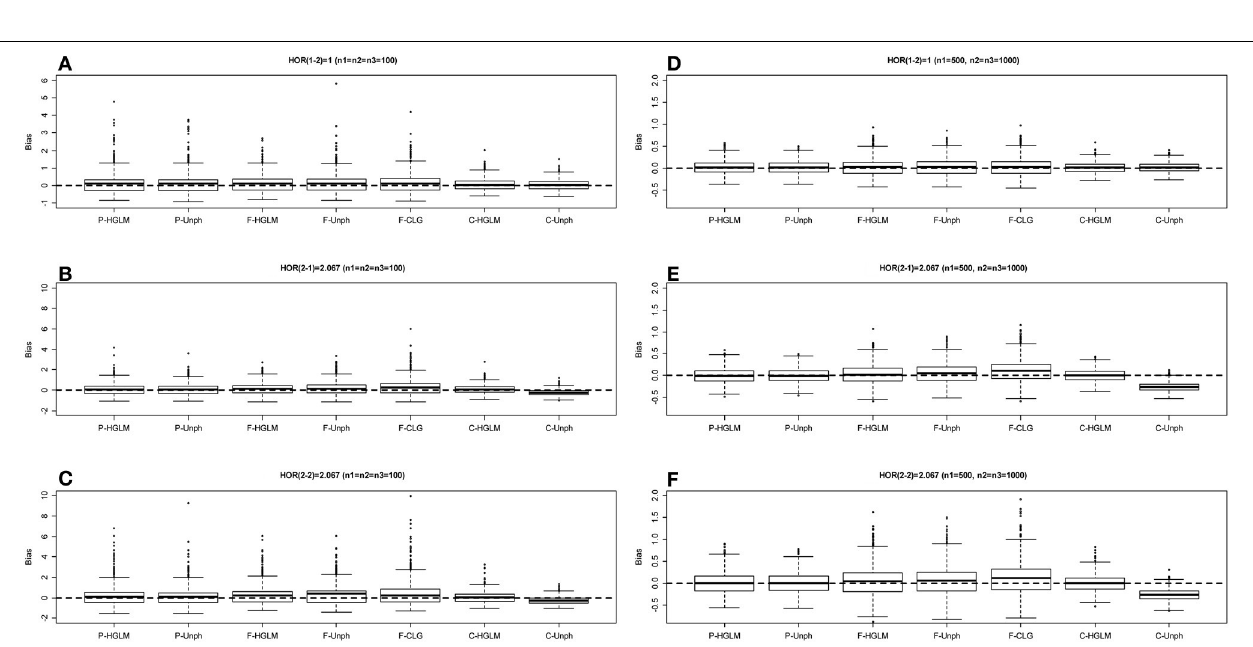
FIGURE 4 | Boxplot of estimate biases (estimate—true HOR) for haplotype odds ratios (HOR) based on moderate effect model over 1000 replications. (A–C) Denotes the HOR = 1, 2.067, 2.067 for n 1 = n 2 = n 3 = 100 and (D–F) is HOR = 1, 2.067, 2.067 for n 1 = 500 , n 2 = n 3 = 1000.